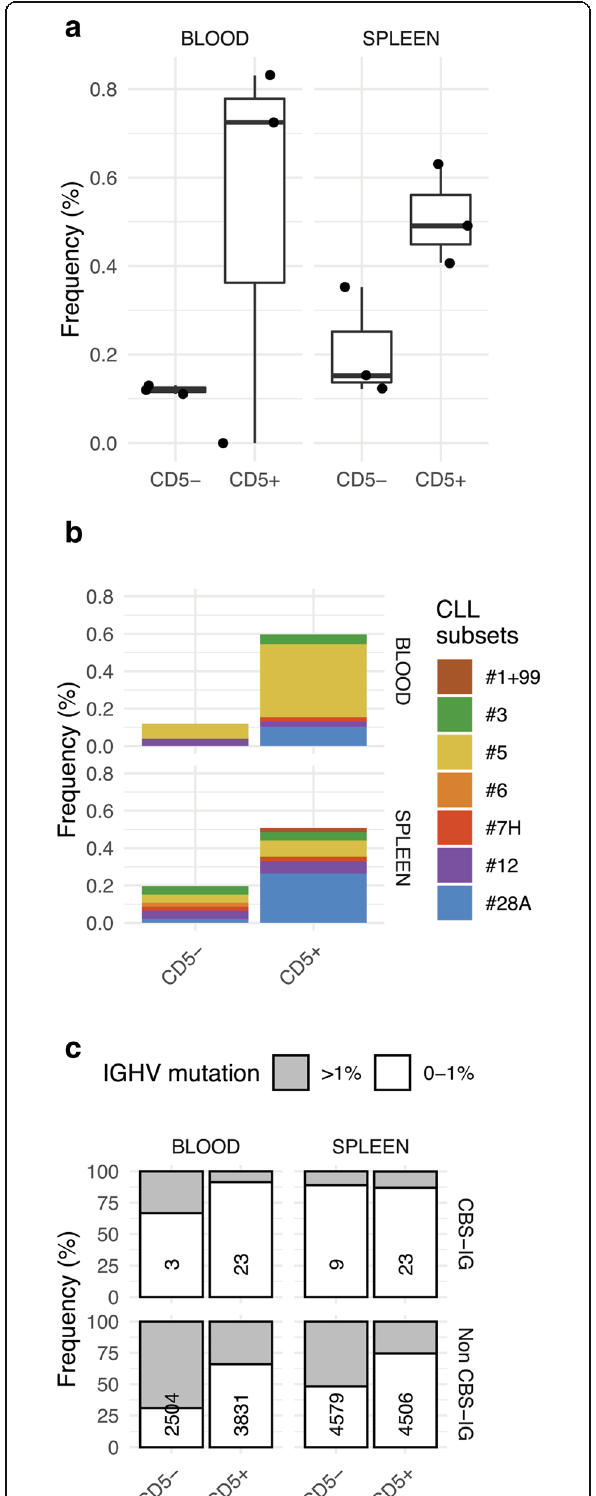
Fig. 4 a Box-plots of the frequency (%) of CSB-IG rearrangements in CD5 + and CD5 - B cell fractions from three PB and from three spleen samples. Each dot represents a single individual. CD5 + B cells expressed higher number of CBS-IG rearrangements ( p = 0.002PB; p = 0.01 spleens) irrespective of their location, PB or spleen. b CLL stereotyped subset distribution in the CBS-IG rearrangements of CD5 + and CD5 - B cells. CLL stereotype subsets are marked by different colours as indicated. c Frequency of mutated and unmutated rearrangements in CBS-IG and in non CBS-IG rearrangements in the CD5 + and CD5 - B cells as